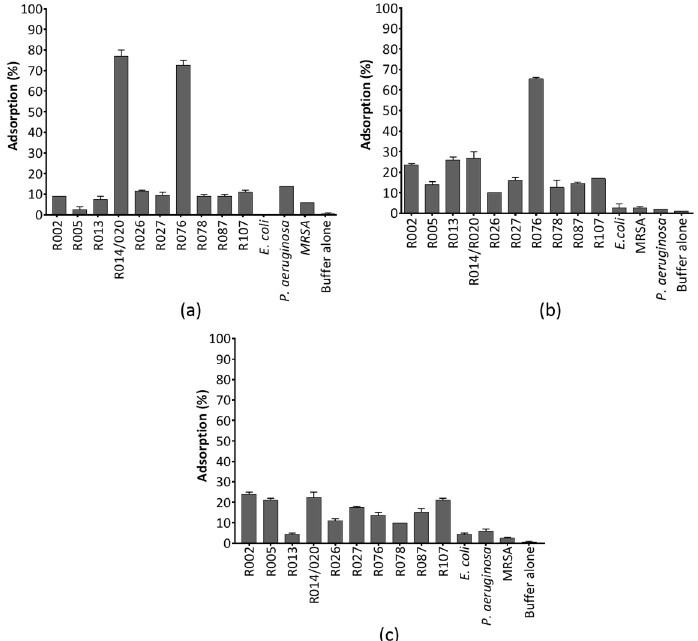
Figure 1. The adsorption of phages CDHM1 ( a ), CDHM3 ( b ) and CDHM6 ( c ) to ten representative isolates of clinically relevant C. difficile ribotypes and representative E. coli , P. aeruginosa and MRSA strains. A phage-only control in buffer alone was included. Bar graphs show phage adsorption after 30 min. Bars represent average percentage adsorption from three independent experiments, each with three technical repeats and error bars represent standard error of the